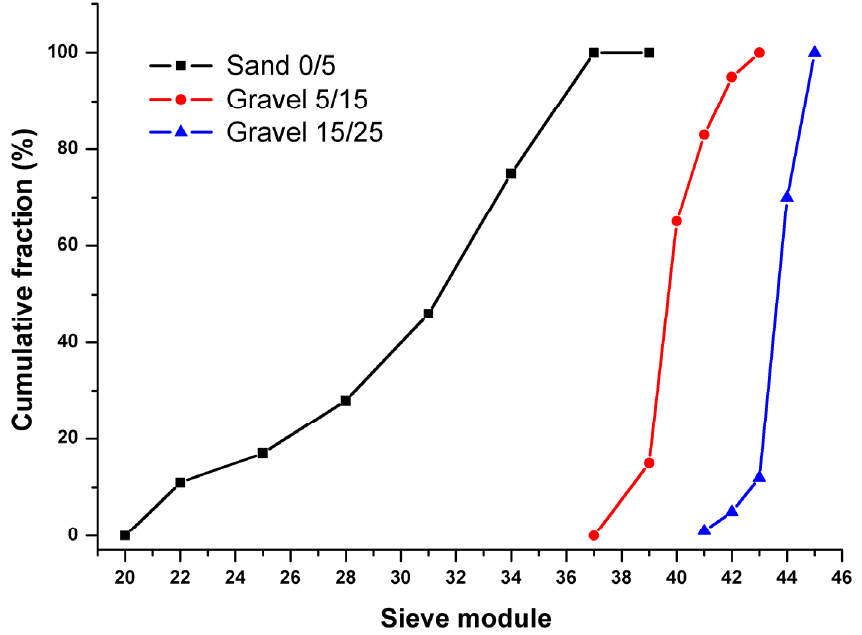
Figure 1. Grading curves of calcareous crushed aggregates according to NF P18-560.